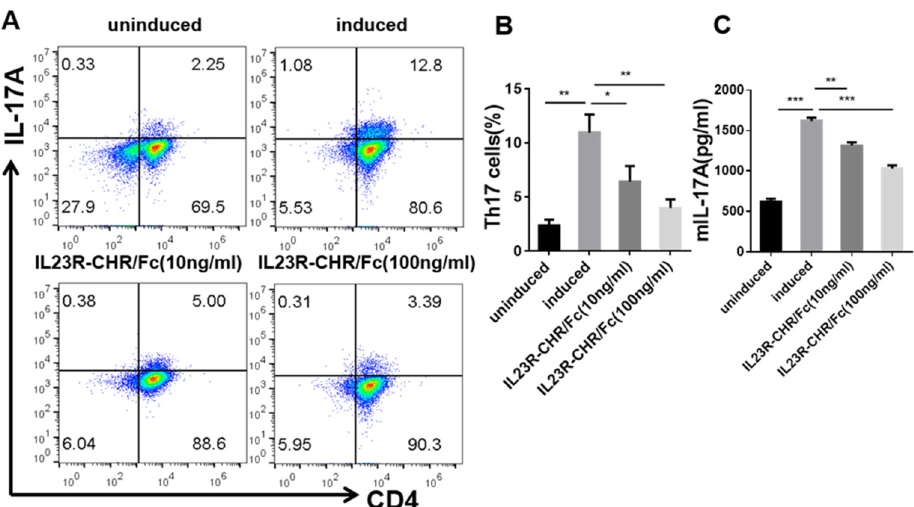
Figure 2. Role of rhIL-23R-CHR/Fc in mouse Th17 cell differentiation. Mouse naive CD4 + T cells were differentiated into Th17 cells in the presence of different concentrations of rhIL23R-CHR/Fc in vitro. ( A ) Analysis of Th17 cells (CD4 + IL-17 + ) by flow cytometry. ( B ) The percentage of Th17 cells. ( C ) IL-17A level in supernatants derived from cultured spleen cells. All tests were performed in triplicate and are presented as the mean ± SEM. * p < 0.05; ** p < 0.01; and *** p < 0.001.